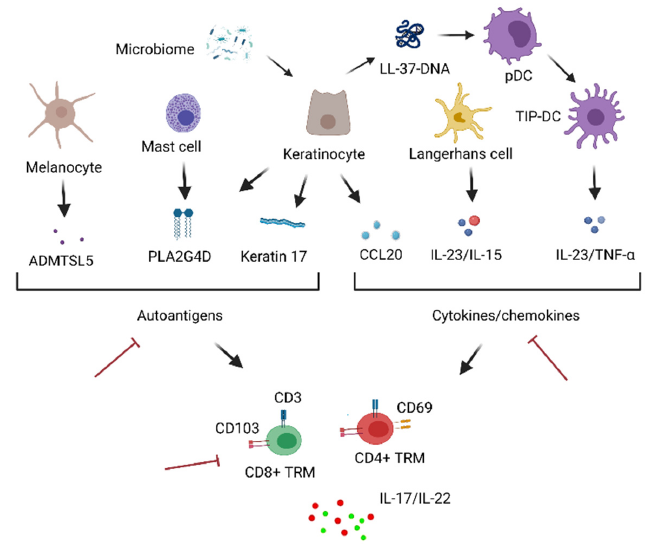
Figure 2. Development of T RM in psoriasis. T RM are activated by either autoantigens or cytokines/chemokines. Autoantigens include ADMTSL5 on the surface of melanocytes, PLAG4D from mast cells and keratinocytes, and keratin 17 from keratinocytes. Antimicrobial peptide LL-37, also from keratinocytes, binds to self-DNA to activate pDC and TIP-DC, leading to the production of IL-23/TNF- α . IL-23/15 from Langerhans cells and CCL20 from keratinocytes also activate T RM . These stimulated T RM produce proinflammatory cytokines, such as IL-17A and IL-22, the hallmarks of psoriasis. The development of pathogenic T RM can be inhibited by stopping pathways related to T RM activation or directly inhibiting the activity of T RM (red inhibition icon). Created with BioRender.com (assessed on 21 August 2021).